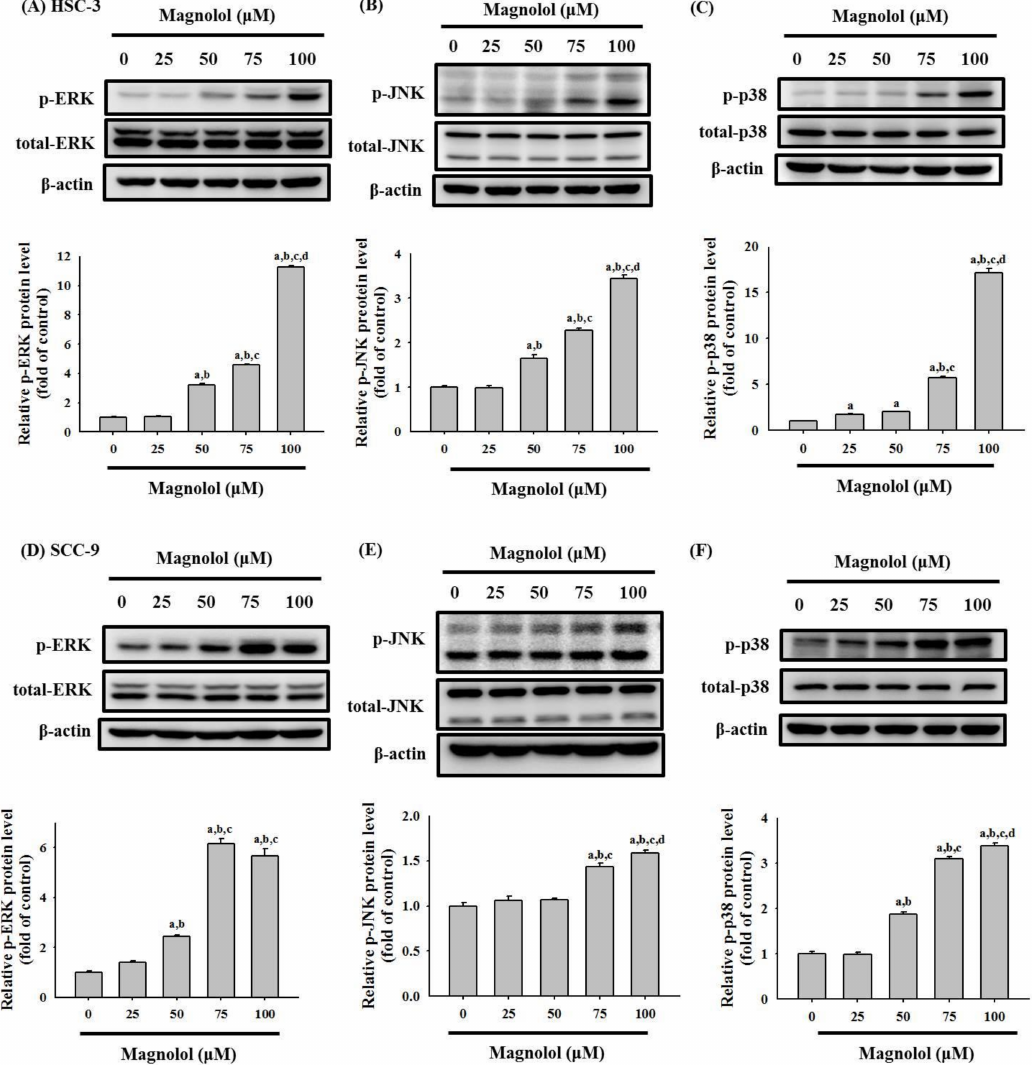
Figure 6. Magnolol activated the MAPK pathway in the HSC-3 and SCC-9 cell lines. ( A – C ) HSC-3 cells and ( D – F ) SCC-9 cells were treated with magnolol (0, 25, 50, 75, and 100 µ M) for 6 h. The phosphorylated levels of ( A , D ) ERK1/2, ( B , E ) JNK1/2, and ( C , F ) p38 were assessed using Western blot analysis, as described in the Materials and Methods section. The data represent the mean ± SD of three independent experiments. a Significantly different, p < 0.05, when compared to control. b Significantly different, p < 0.05, when compared to 25 µ M. c Significantly different, p < 0.05, when compared to 50 µ M. d Significantly different, p < 0.05, when compared to 75 µ